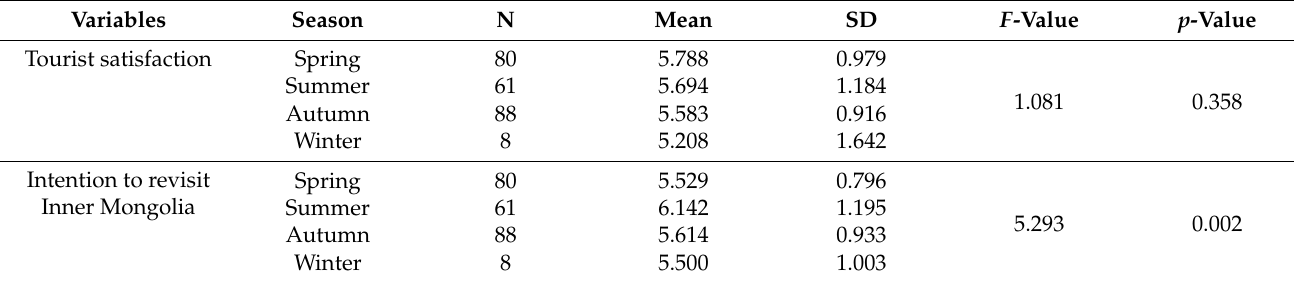
Table 7. Results of ANOVA: season differences in tourist satisfaction and Intention to revisit Inner Mongolia.